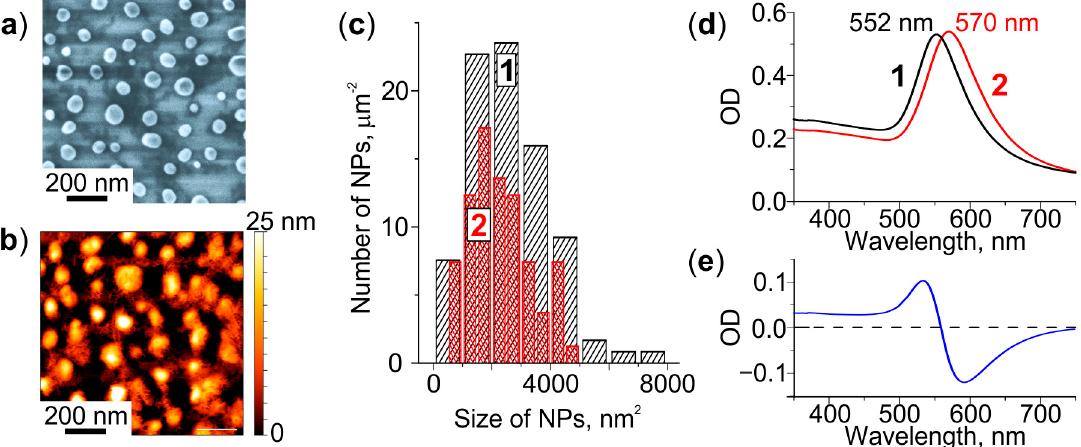
Figure 1. Characterization of the glass with Au NPs. ( a ) SEM and ( b ) AFM images. ( c ) NPs size distributions before (1) and after (2) cleaning of the glass surface. ( d ) Extinction spectra of the as-received (1) and cleaned (2) glass, ( e ) corresponding differential